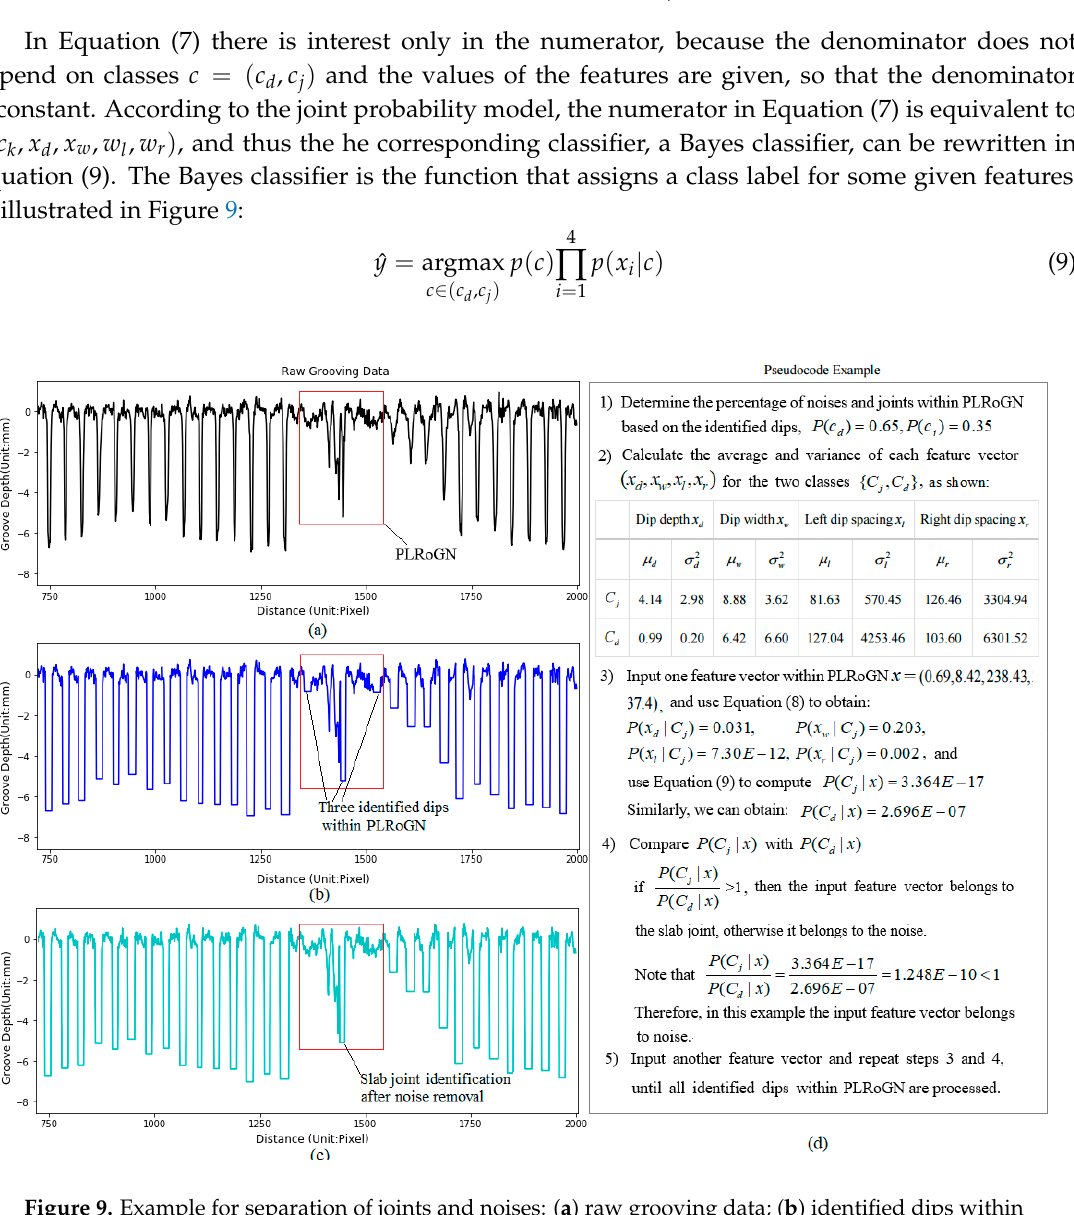
Figure 9. Example for separation of joints and noises: ( a ) raw grooving data; ( b ) identified dips within PLRoGN; ( c ) identified joint after noise removal; ( d ) flowchart for the separation of joints and noises.